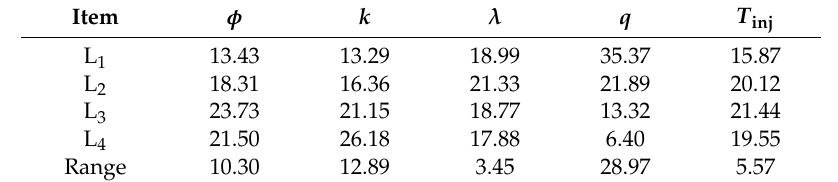
Table 10. Mean effects of different levels of conditions on the energy efficiency at t = 20 years.